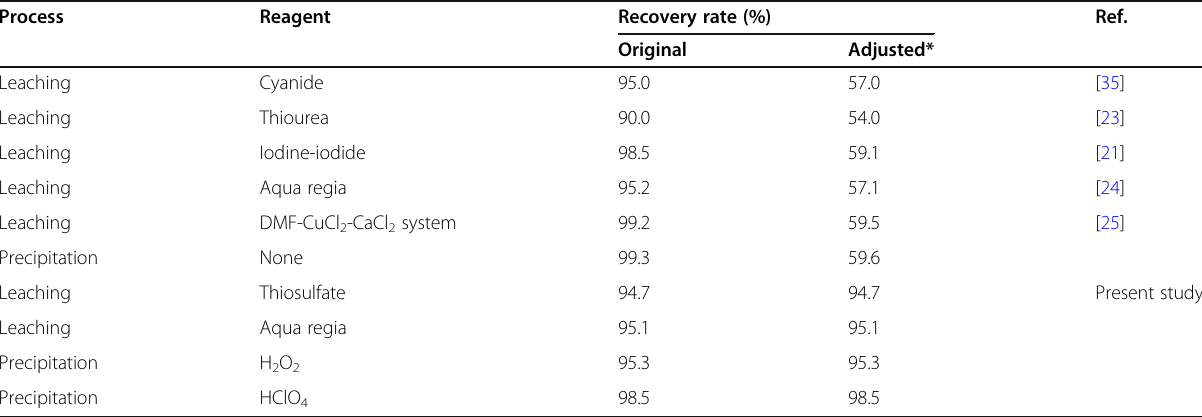
Table 3 Studies regarding gold recovery from waste PCBs